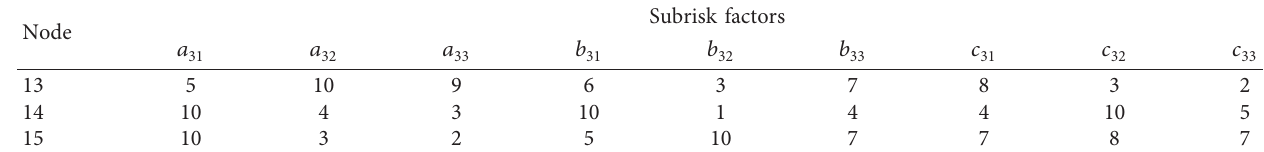
Table 9: Scoring results of subrisk factors of the third-level nodes.